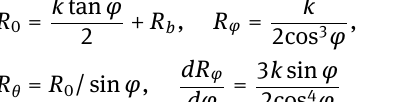
, R . For a surface of revolu- φ θ